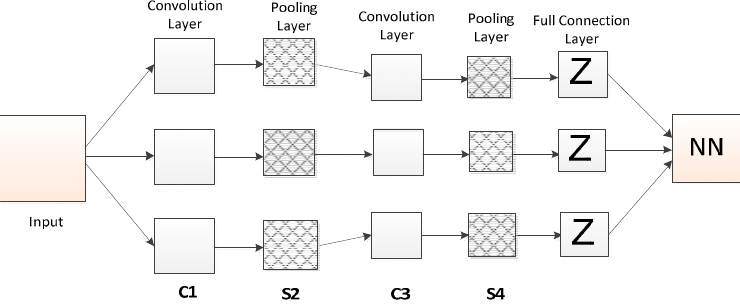
Figure 10. Structure diagram of convolution neural network (CNN).